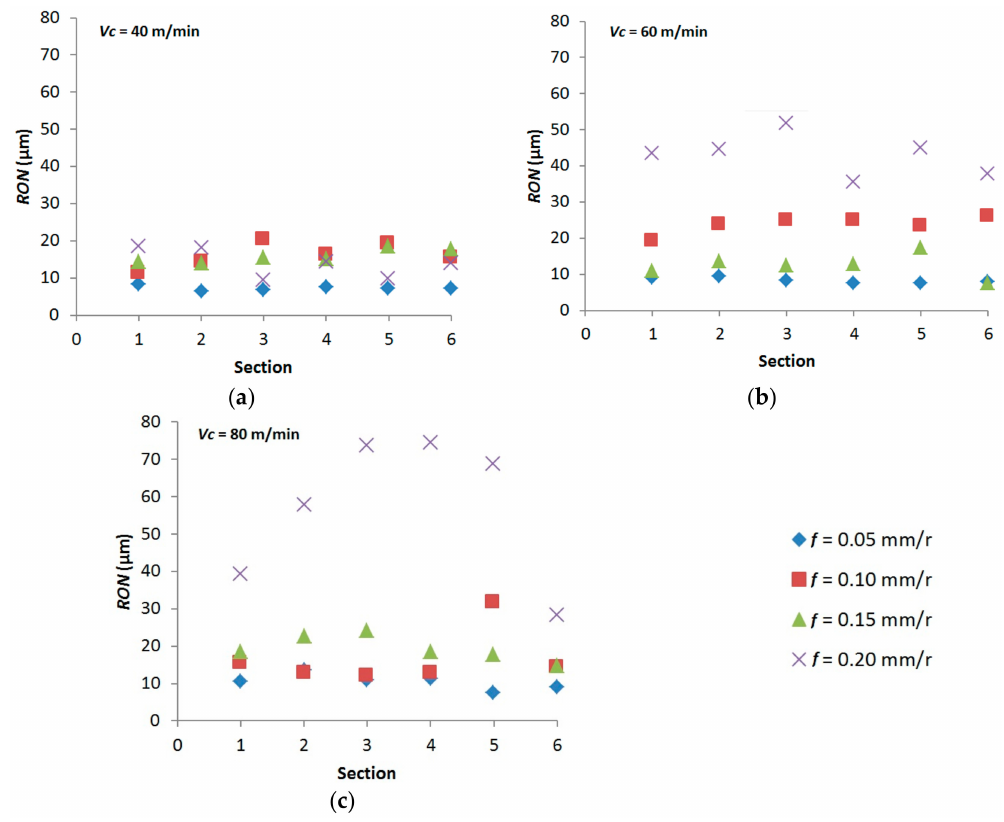
Figure 12. Roundness deviations for ( a ) v c = 40 m / min, ( b ) v c = 60 m / min and ( c ) v c = 80 m / min.